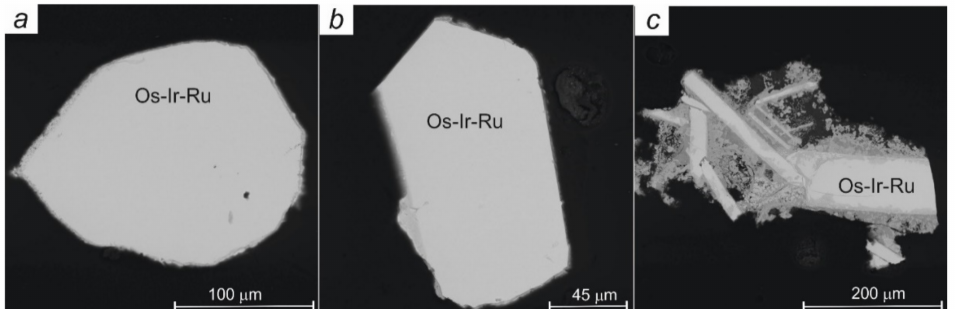
Figure 2. Back-scattered electron (BSE) images showing morphological and textural features of placer grains PGM from the alluvial placer of the r. Kitoy: ( a ) a partly round grain Os-Ir-Ru alloy; ( b ) hexagonal idiomorphic grain Os-Ir-Ru alloy; ( c ) intergrowths of subidiomorphic crystals of Os-Ir-Ru